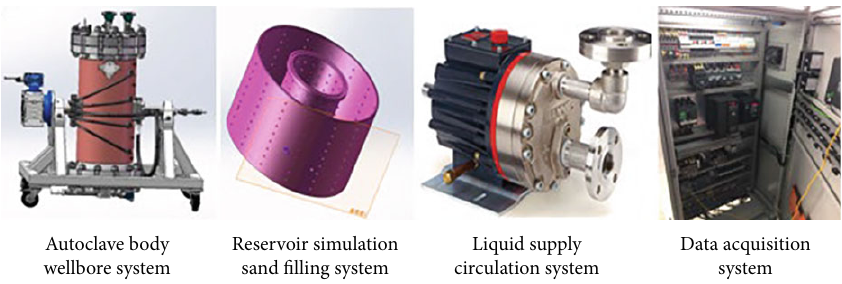
Figure 4: Schematic diagram of the sand control experimental